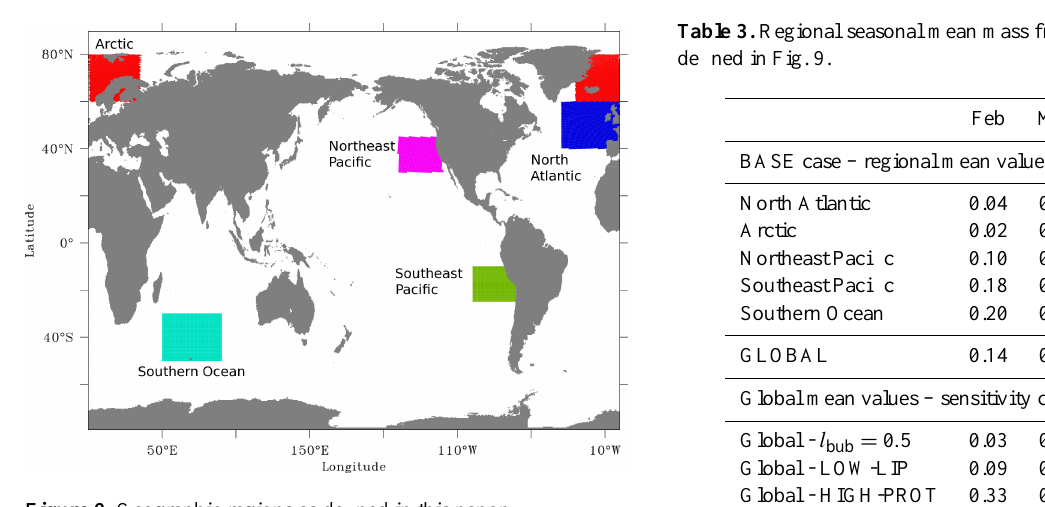
Figure 9. Geographic regions as defined in this paper.